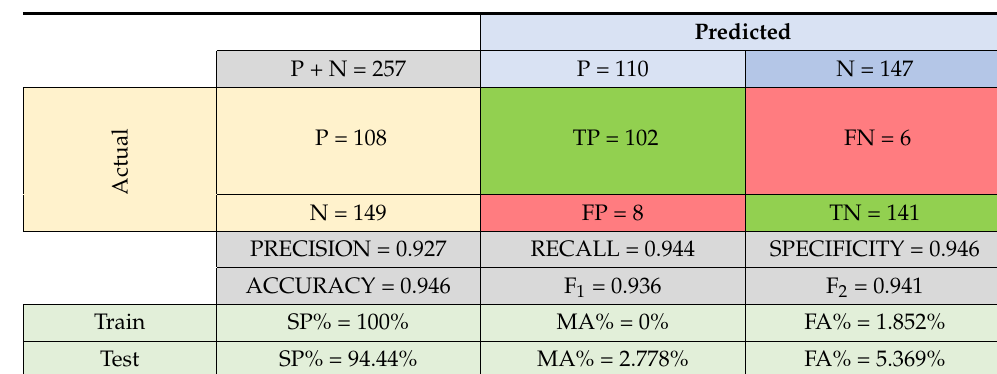
Table 8. Confusion matrix and performance indices of the MLP-NN prediction model evaluated on the test set.